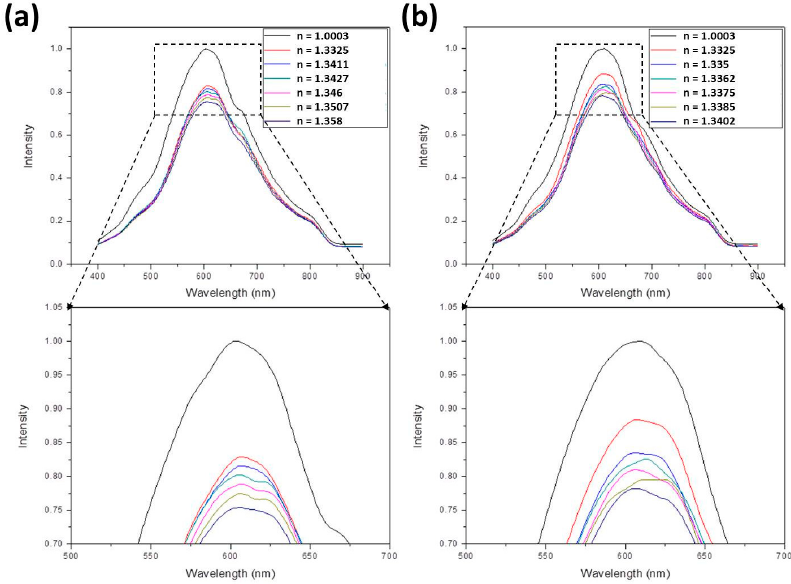
Figure 5. The normalized surface plasmon resonance (SPR) spectra of ( a ) ethanol and ( b ) methanol solutions with different refractive indices.